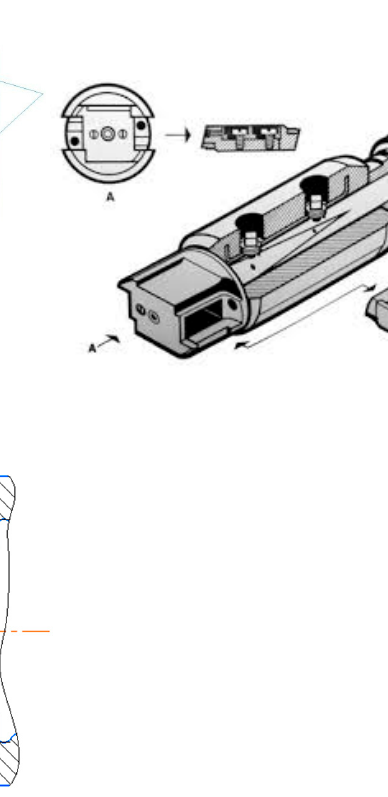
Figure 8. Developed boring head.